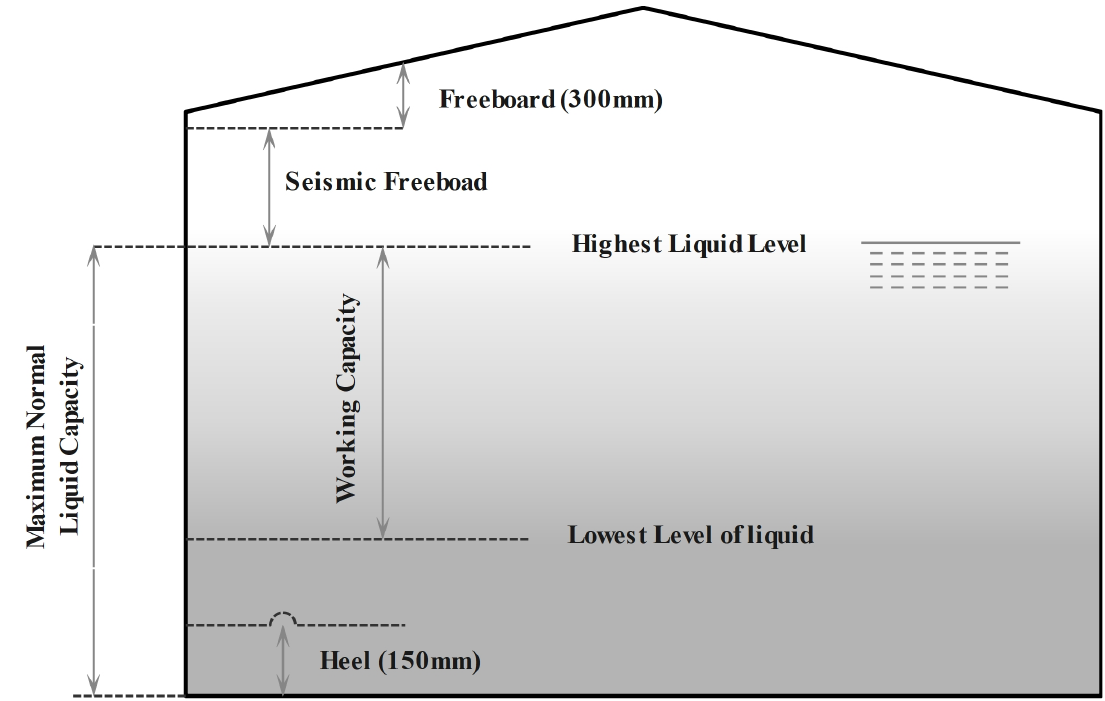
Figure 8. The schematic of the mandatory levels to be observed in a cryogenic tank .